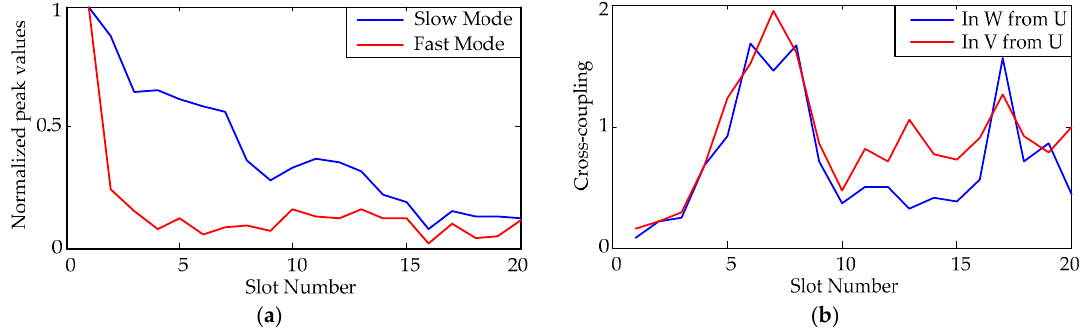
Figure 4. Propagation characteristics of PD signal in stator winding ( a ) Attenuation of fast and slow modes; ( b ) Cross-coupling from phase U to phase V and W, revised after [40].